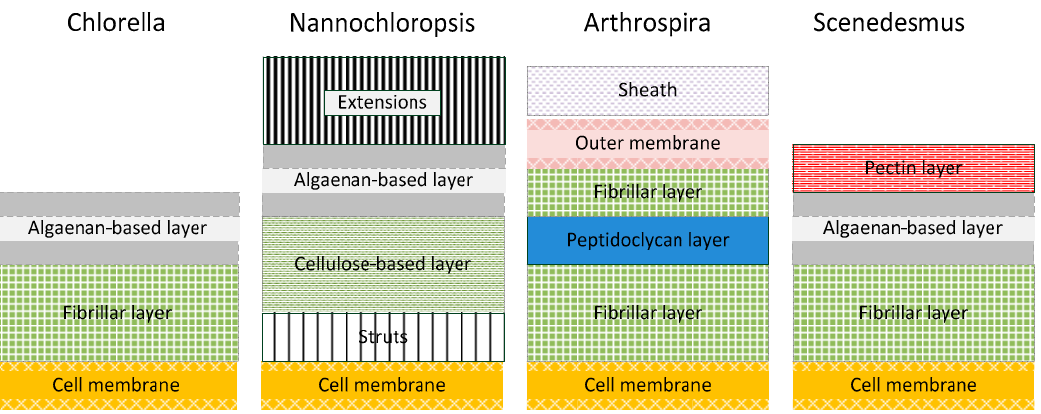
Figure 7. Schematic view of cell wall structures, modified from [33].